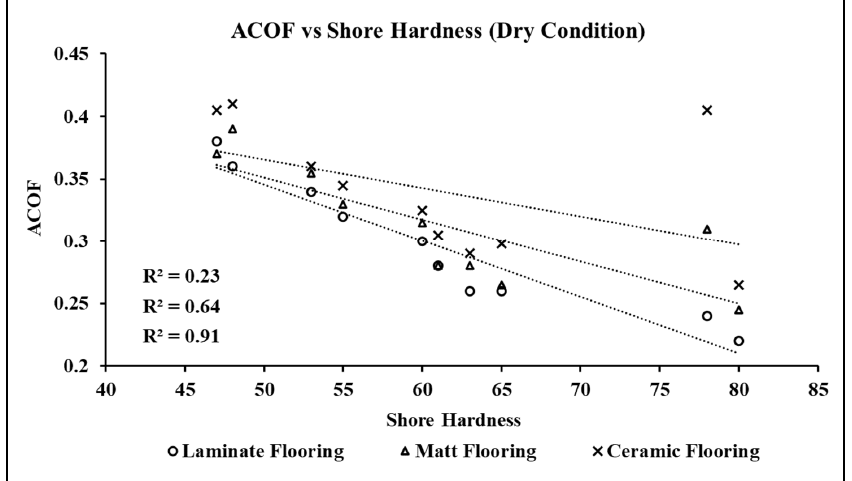
Figure 10. Correlation between shore hardness and ACOF across the shoes in dry slipping condi ‐